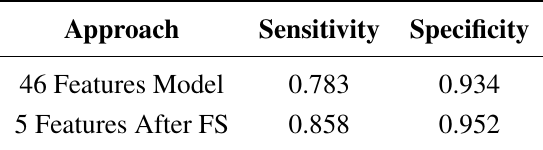
Table 2. Comparison of the 46 and 5 features residential home